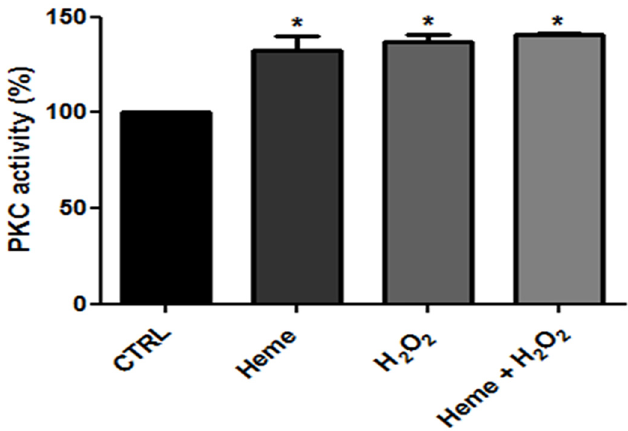
Fig 9. Effect of hydrogen peroxide on the PKC activity in L . amazonensis . Intact promastigotes were incubated for 20 minutes in a reaction medium containing 2.5 M heme or 0.1 μ M hydrogen peroxide, or both compounds together, as indicated on the abscissa. The data indicate mean enzyme activity ± SE of at least three experiments, each with different cell suspensions. * Statistically significant when compared to control (n = 3, P < 0.05). CTRL, control.